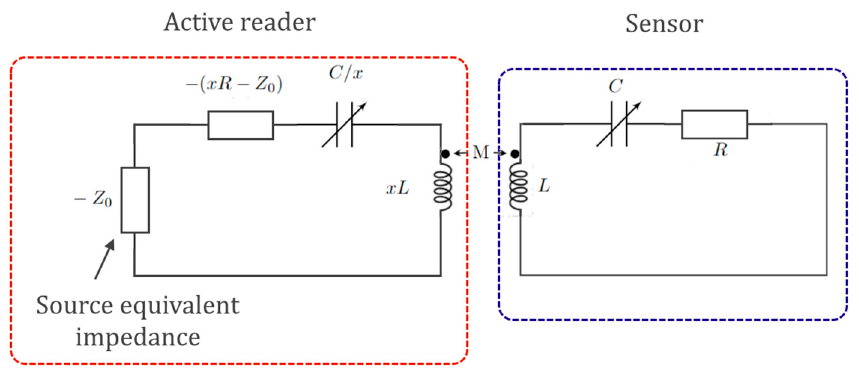
Figure 17. Equivalent circuit model for the PTX-symmetric telemetric sensor. The active reader interrogates the sensor via magnetic coupling. The parameter x is the scaling parameter. For x = 1, the PTX degenerates into PT symmetry (architecture proposed in [99]). The source is modelled via an equivalent impedance − Z 0 . The voltage impedance-controlled converter.